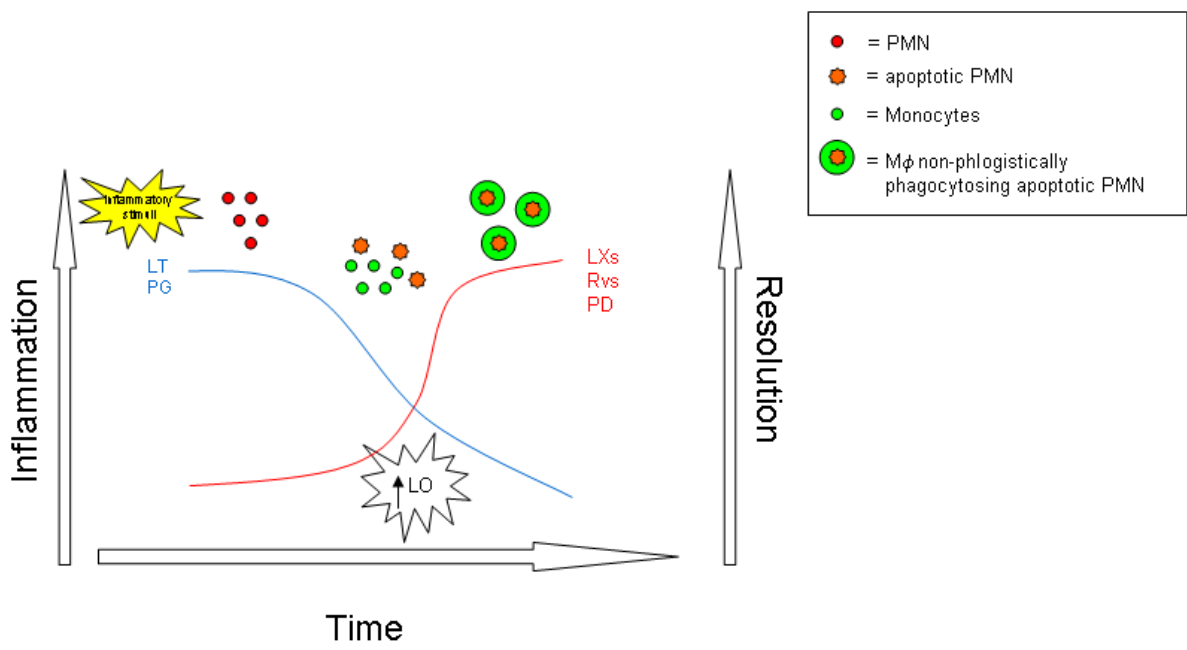
FIGURE 1. Temporal lipid inflammation and its resolution . Leukotrienes (LT) and prostaglandins (PG) are synthesized in response to an inflammatory stimulus. These induce vasodilatation and facilitate the recruitment of polymorphonuclear cells (PMNs) into the tissue, which attempt to rid the tissue of the inflammatory stimuli and clear tissue debris. As the inflammation progresses, PGs induce transcription of 15- lipoxygenase (LO) in neutrophils, which induces the formation of lipoxins (LXs), and potentially also resolvins and protectins[5]. These mediators promote the resolution of inflammation by inhibiting PMN infiltration, while stimulating the recruitment of monocytes, inducing a shift in the cytokine milieu and stimulating macrophage (M  phagocytosis of apoptotic PMN in a nonphlogistic